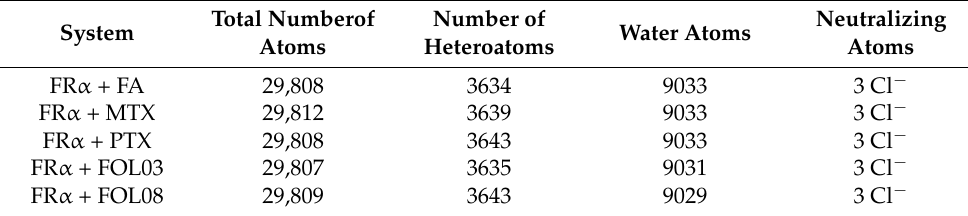
Table 5. MD system setup